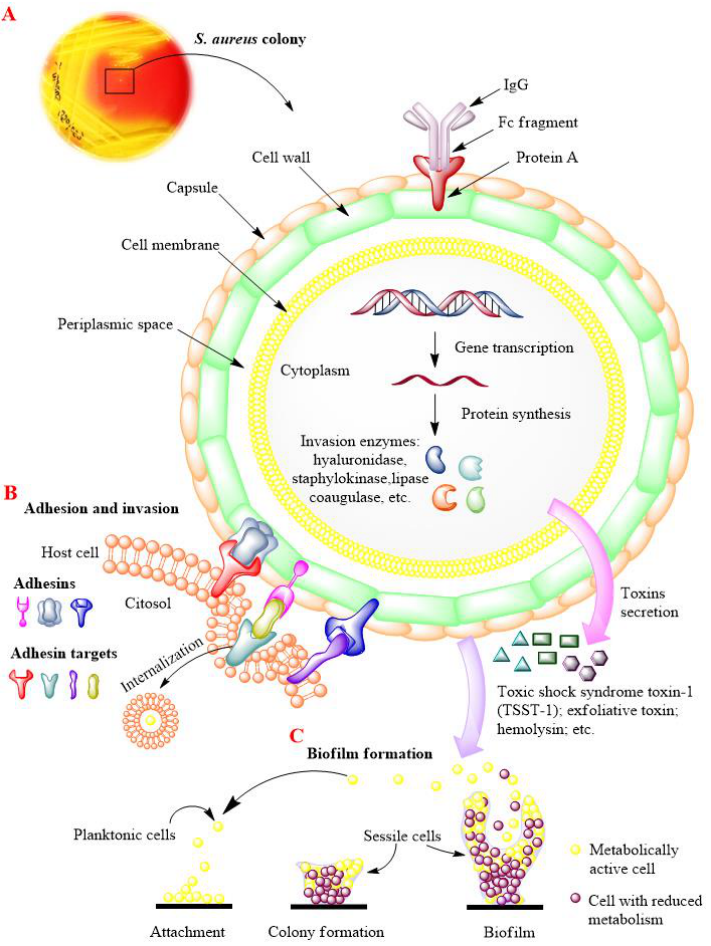
Figure 1. Schematic model of the virulence factors of S. aureus . ( A ). Cell structure of S. aureus . The cell-wall contains several proteins, including Protein A which binds the Fc fragment of immunoglobulin-G (IgG), blocking its phagocytic activity, and the adhesins, which mediate the adhesion and invasion of the bacterium to the host cell. Besides, S. aureus synthesizes different exoenzymes, which facilitate its dissemination and tissue invasion. This pathogen is also able to secrete a large variety of toxins, responsible for severe diseases. ( B ). Molecular mechanisms involved in the adhesion and invasion of S. aureus to host cell. The binding of surface adhesins with specific cellular receptors or with the component of extracellular matrix triggers a signalling cascade that culminates with bacterial internalization. ( C ). Biofilm formation stages. Favorable environment conditions promote the formation of biofilm, which consists of three different stages: attachment of free bacteria (planktonic cells) to the abiotic surface (e.g., medical devices); initial synthesis of biofilm and formation of bacterial colony inside the biofilm (sessile bacteria) and, finally, complete biofilm formation. The bacteria embedded in the biofilm can reduce their metabolic activity, becoming quiescent. Under specific environment signals, the sessile bacteria can switch to planktonic form, provoking